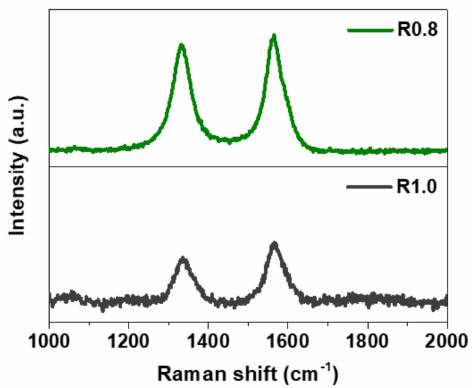
Figure 7. The Raman spectra of spent catalysts after 10 h of DRM